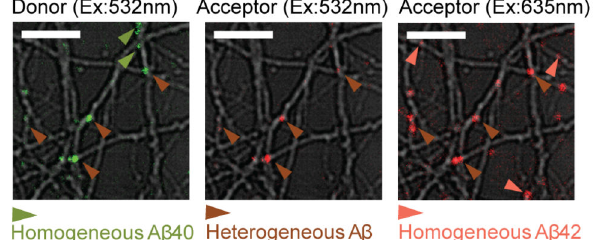
Figure 3. Mixed Aβ40-HL555 and Aβ42-HL647 are incubated with neurons and show FRET. Homogeneous Aβ40 (green arrow) is imaged by 532 nm excitation but does not show signal in acceptor’s channel. Heterogeneous Aβ (brown arrow) is determined by FRET in Acceptor’s channel upon 532 nm excitation. Homogeneous Aβ42 (pink arrow) is imaged by 635 nm excitation but without FRET. Scale bars are 10 µm.